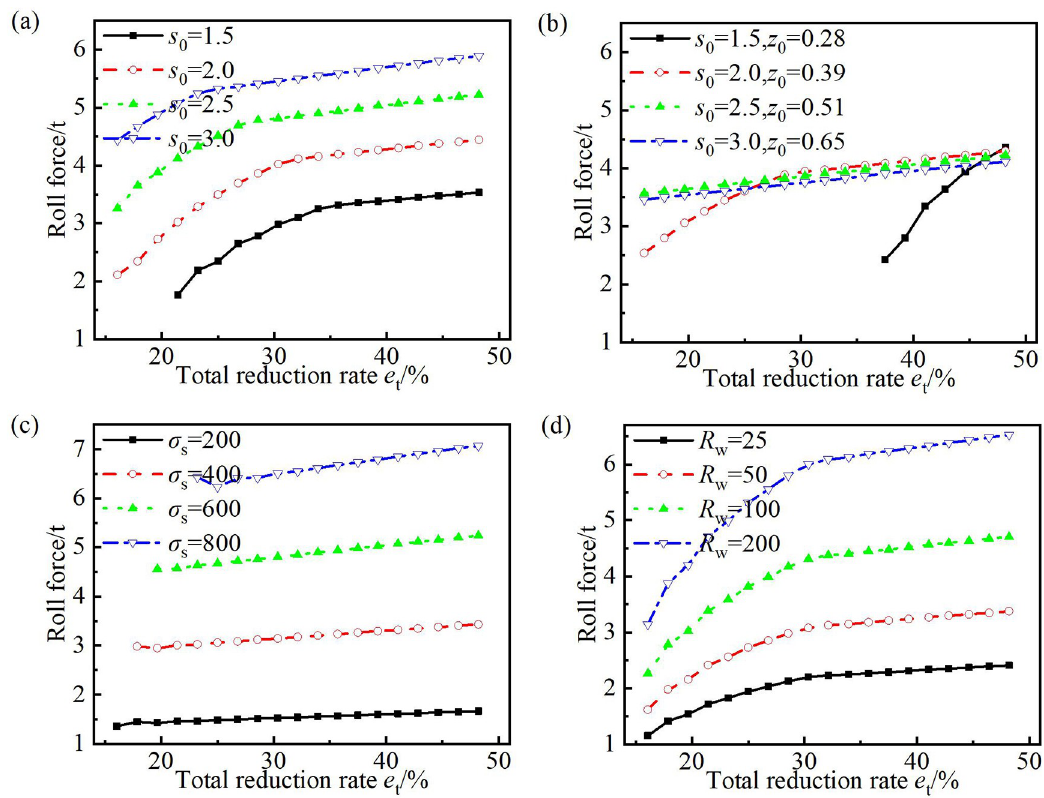
Fig 11. Effect of parameters on roll force. (a) Filling wall thickness, (b) filling wall thickness with the same mass ratio between the core material and the steel tube in a section, (c) yield strength of the steel tube, and (d) work roll radius.